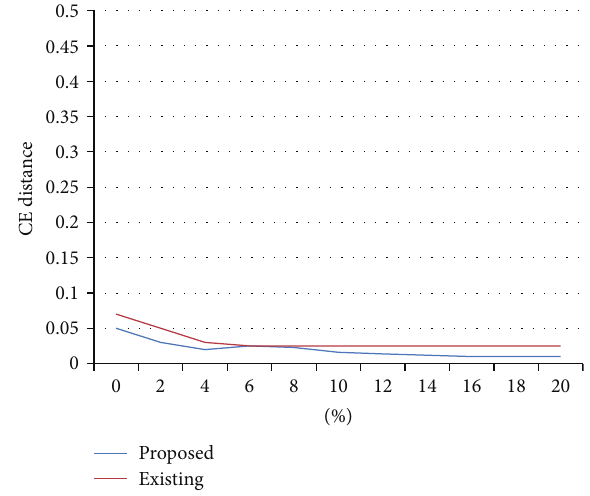
Figure 2: Immunity to outliers for datasets with 𝑙 real = 2 percent of 𝑑